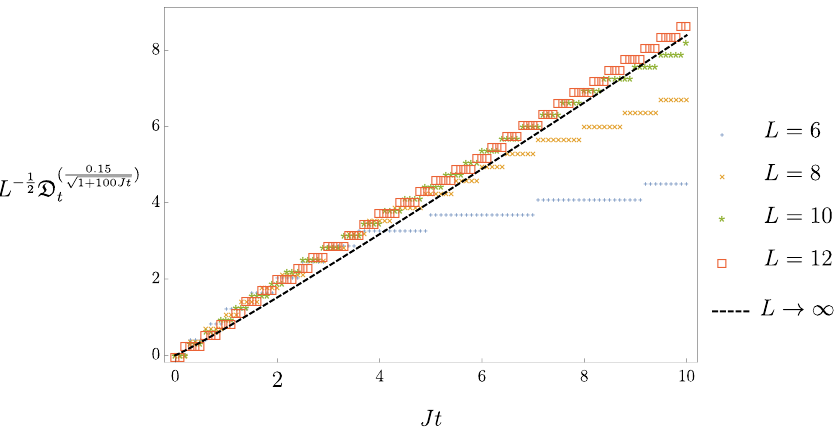
(cid:112) L with probabil- = 0.15 / (cid:112) , with ε 1 + 100 Jt in a small spin- t t